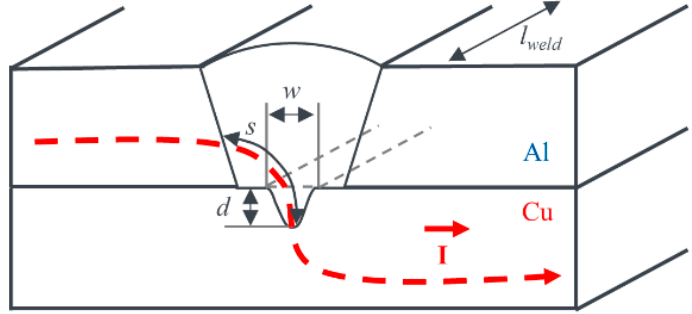
Figure 4. Sketch of a cross-section of the weld seam with indication of the path of an electrical current.